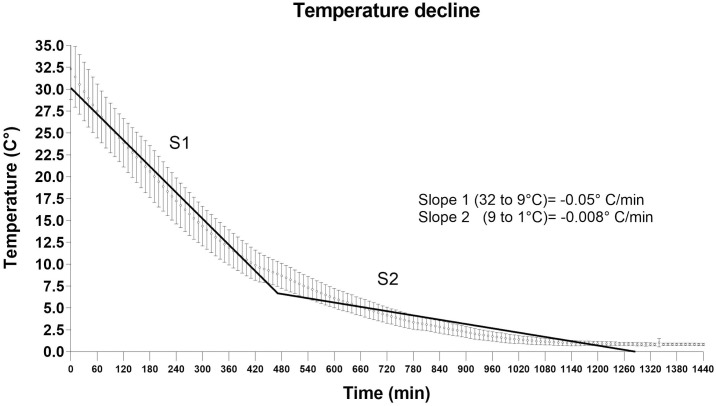
Temperature decline postmortem in steer carcasses M. longissimus thoracis (both categories, n = 12).In the figure, slopes are shown (S1 and S2) corresponding to two components founded by non-linear function analysis.